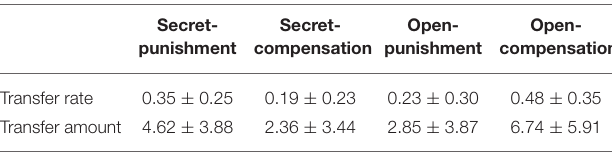
TABLE 5 | Transfer rates and amounts when third parties were free to choose ( M ± SD ). Secret-